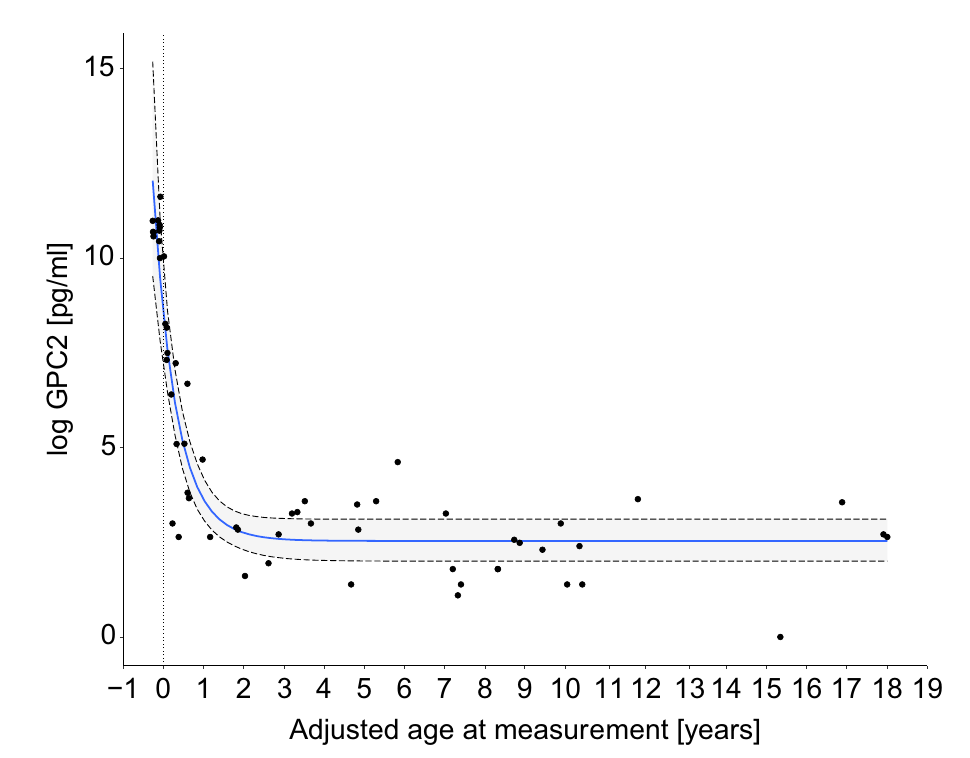
Fig 2. Log concentration of GPC2 by term-born adjusted age at measurements (years) with an asymptotic regression model (blue line) and 95% credible interval (grey area). CSF-GPC2 (Table 3). The detailed parameters of the linear regression models assessing the relation between CSF-DCX/GPC2 and each clinical variable are provided in S5 Table.